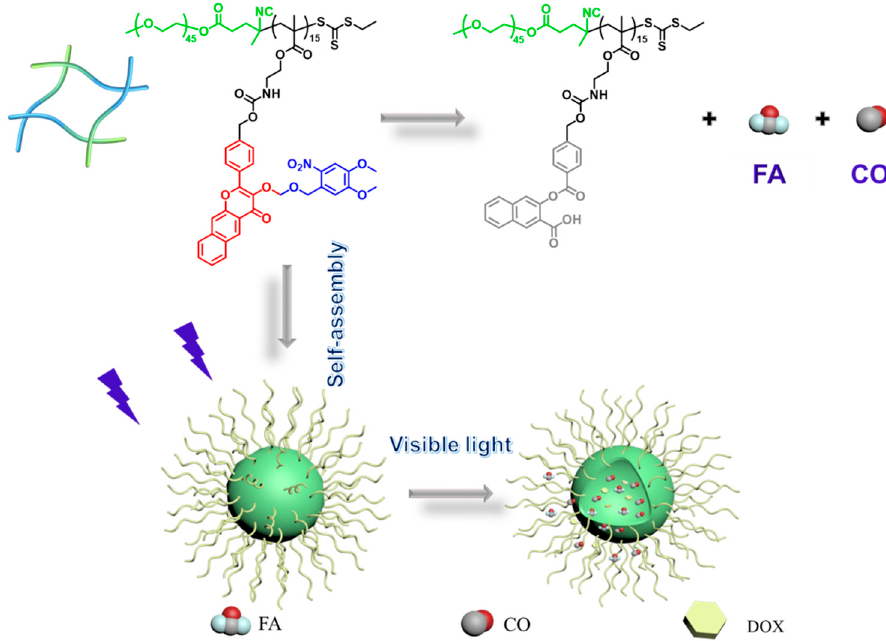
Scheme 1. Schematic illustration of the formation of DOX-loaded micelles self-assembled from PEG-b-PFFM diblock copolymers and the photo-triggered co-delivery of CO, FA and DOX.